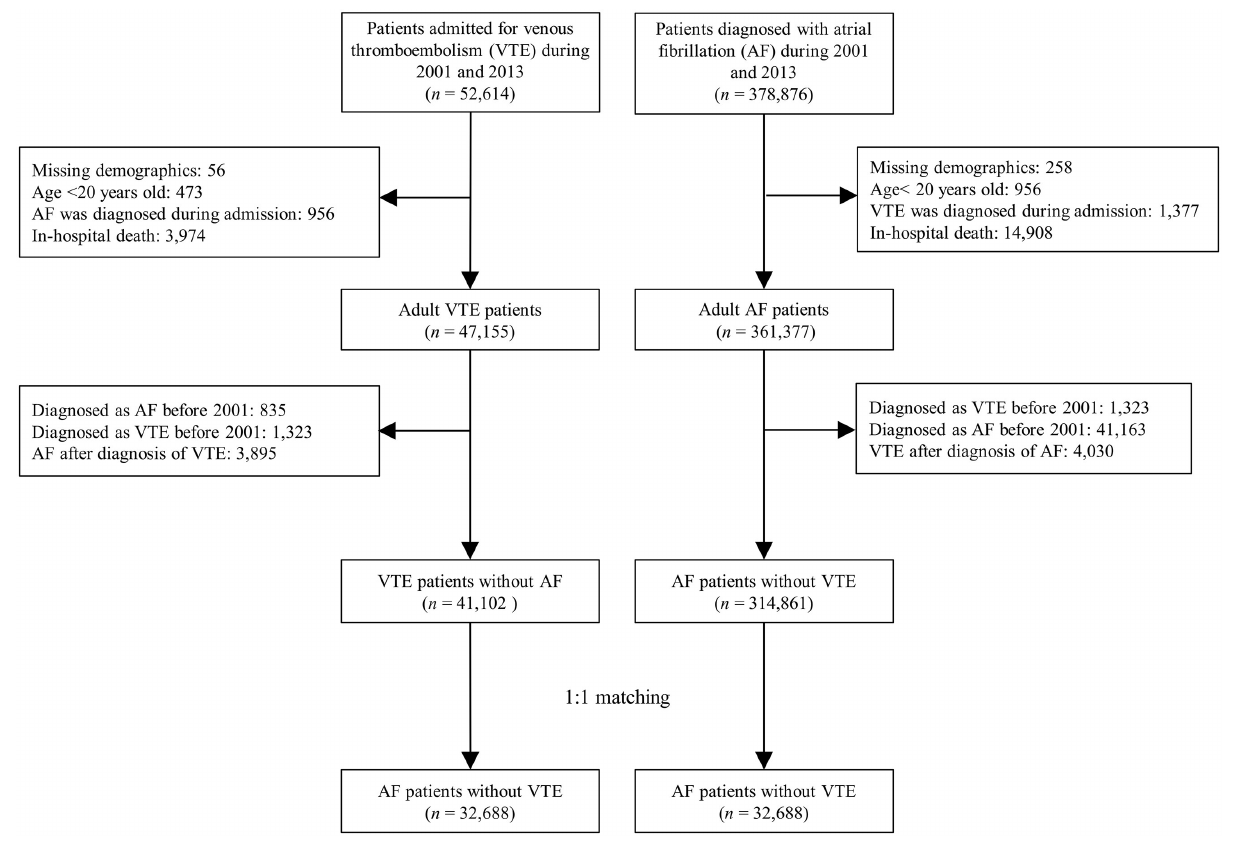
FIGURE 1 | Flowchart for selection of the study